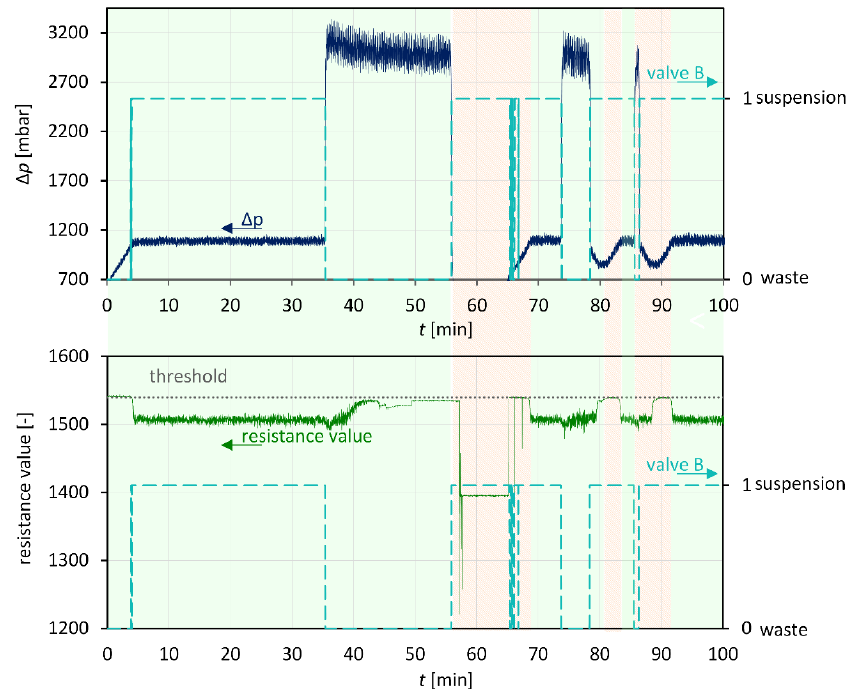
Figure 10. Pressure loss and magnetic valve position for “pressure loss rinsing” (for experiment seed 90–180 2): green background = right magnetic valve position, and red shaded background = magnetic valve got the wrong position.